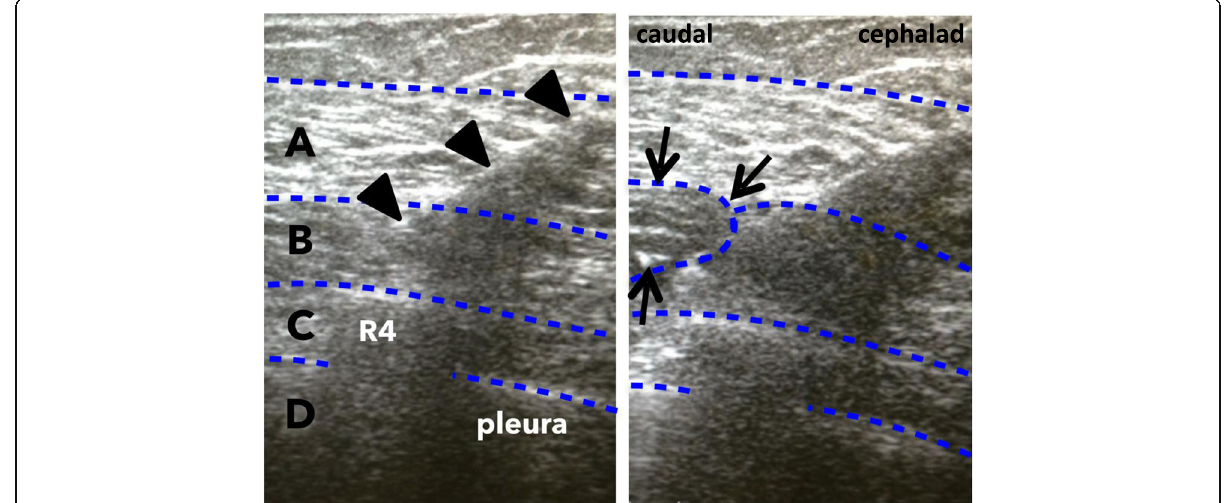
Fig. 1 Ultrasound-guided serratus plane